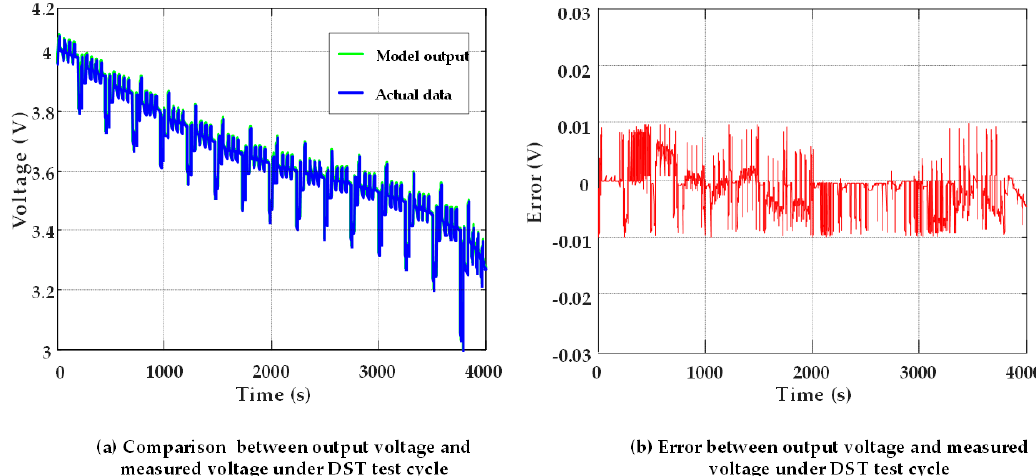
Figure 6. The DST working condition verification of the fractional-order model (FOM).